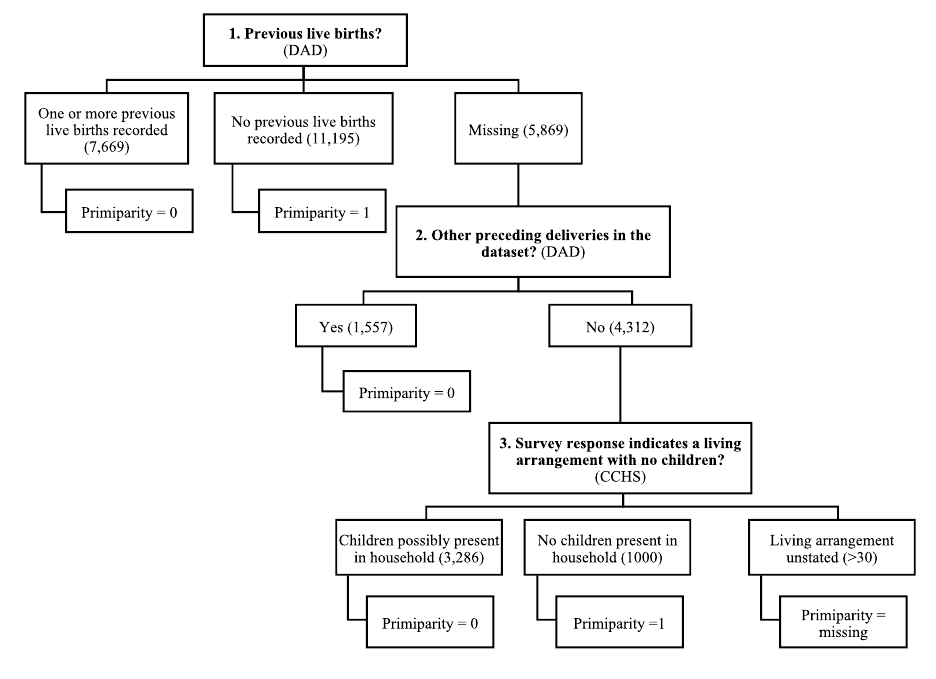
Supplementary Figure 2: Flow chart detailing the algorithm used to identify primiparous women, using variables from the DAD and the CCHS related to having previous children.